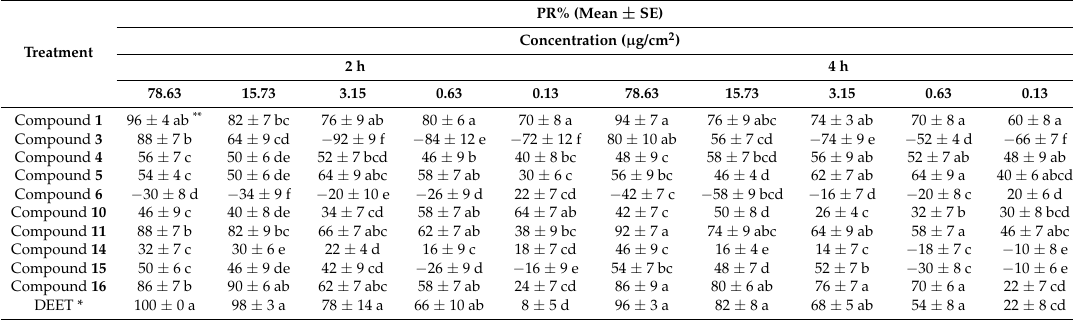
Table 1. Repellent activity of isolated compounds from M. tetramera against T. castaneum .